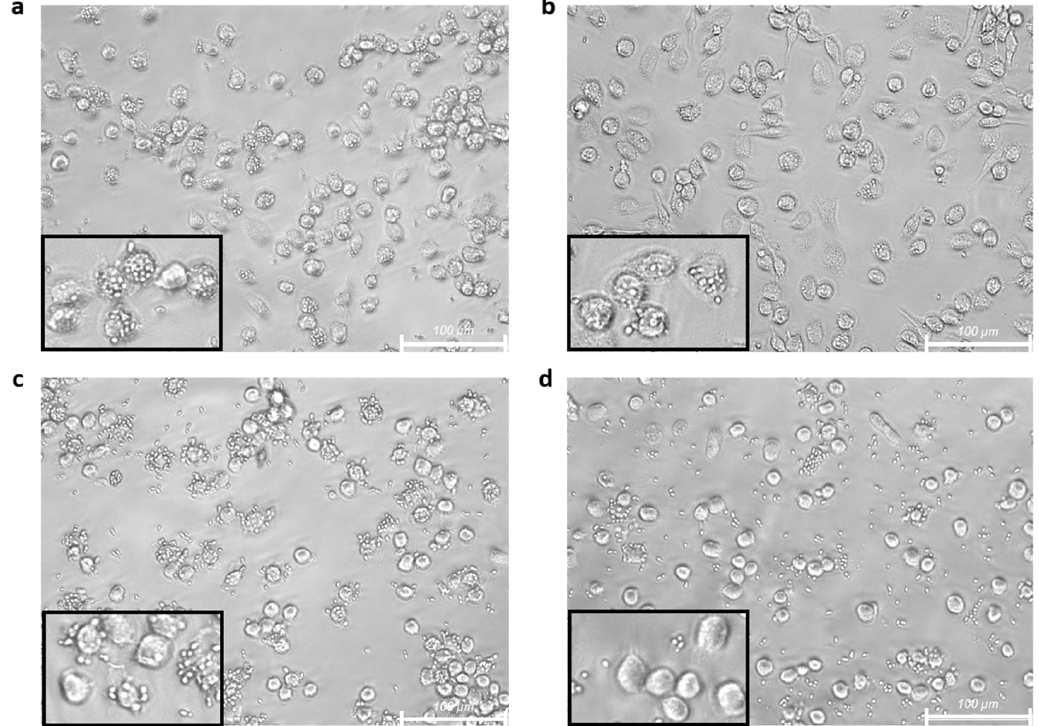
Figure 4. Phagocytosis of heat killed C. albicans mediated by M1 macrophages after treatment with Brassica -derived compounds. LPS stimulated (0.1 µg/mL) human M1 macrophages from 3 healthy donors were untreated ( a ) or treated for 24 h with unloaded broccoli membrane vesicles 0.02 mg/mL ( b ), free sulforaphane 25 µM ( c ), or SFN-loaded broccoli membrane vesicles at 25 µM ( d ). After withdrawal of medium, the cells were cocultured for 2 h with heat killed C. albicans at 1:5 ratio, and then washed with PBS. Representative images from optical microscope with 20 × magnification are shown. Bar scale is 100 µ